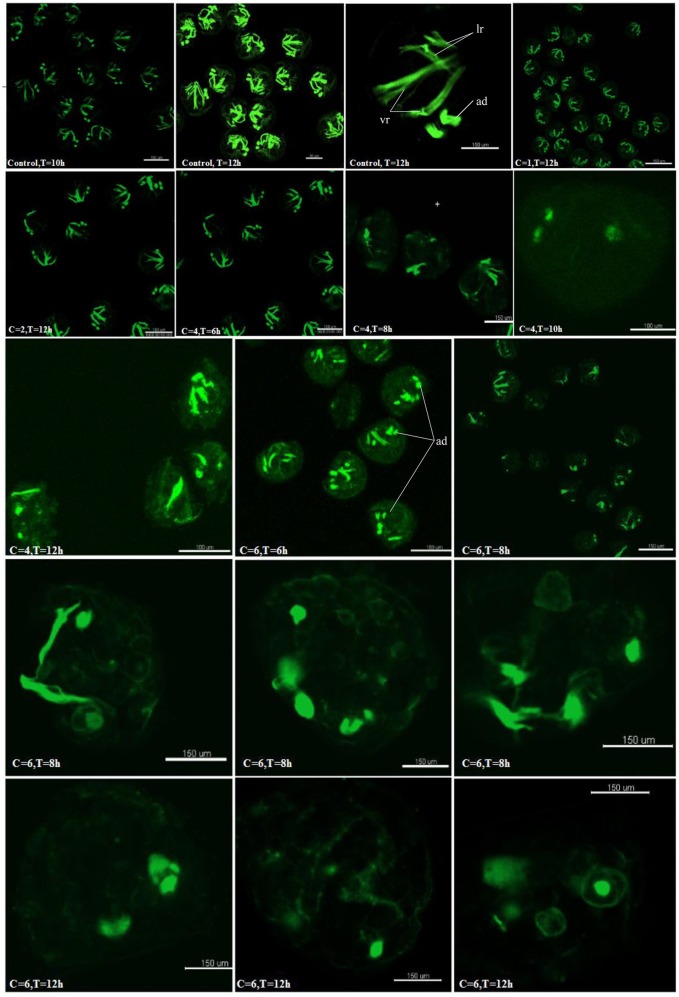
Myogenesis of cyclopamine treated larvae. C represent the concentration of the cyclopamine (μM), T represent the treated time (hour).